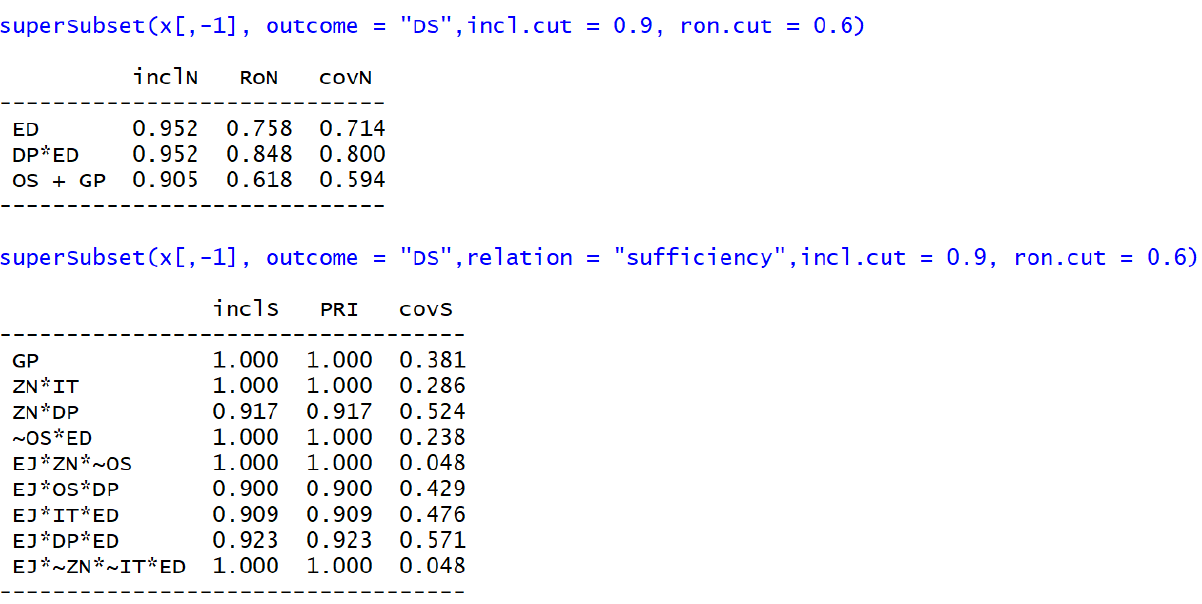
Figure 2. Results of applying the superSubset() function to research survey data.